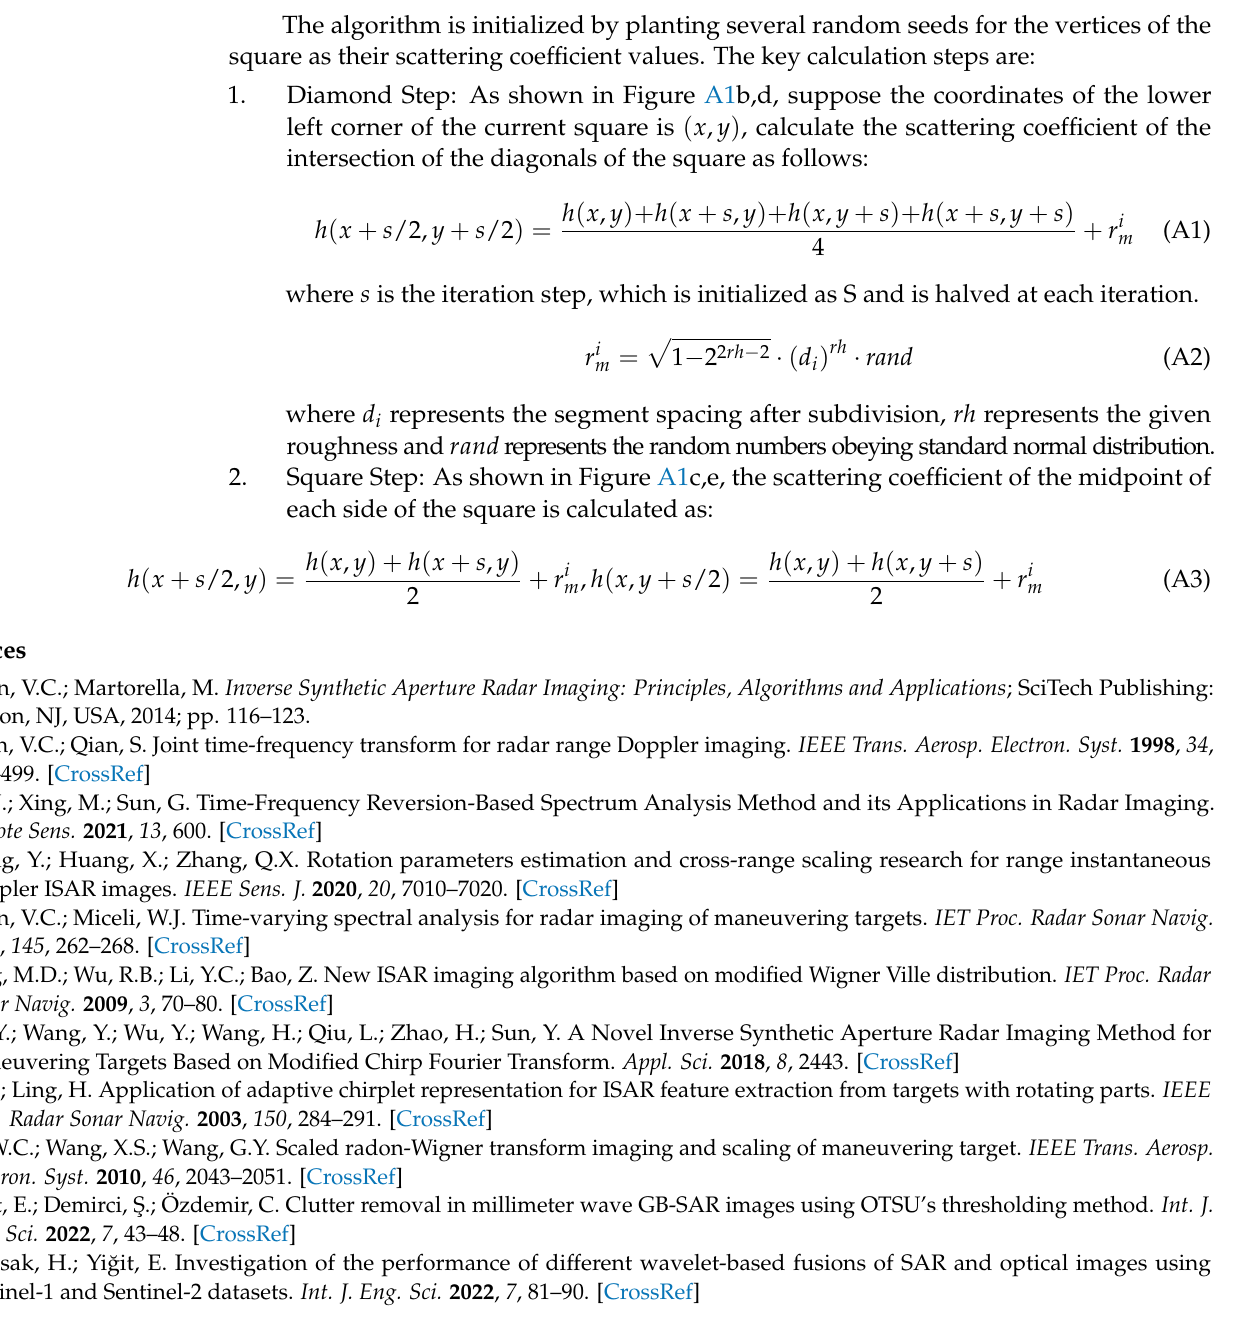
where s is the iteration step, which is initialized as S and is halved at each iteration.